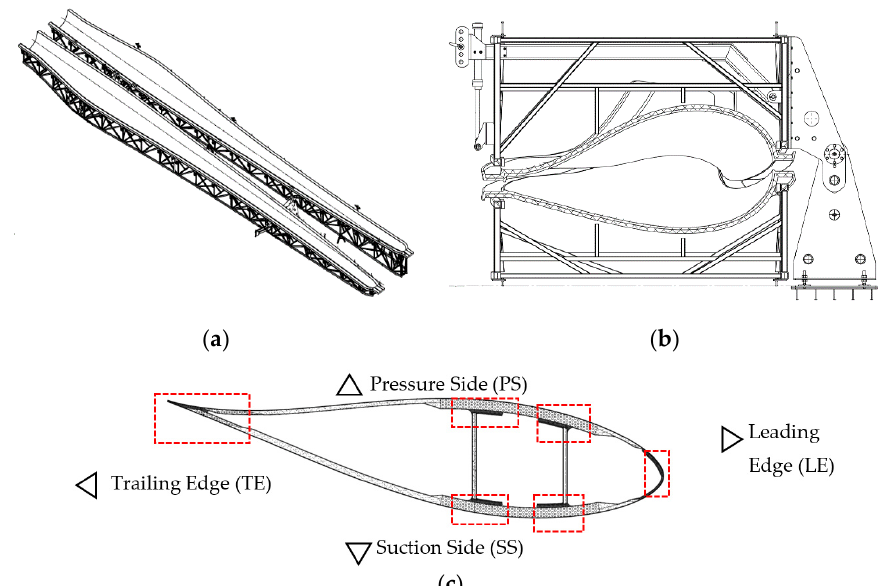
Figure 1. Schematic diagram of blade bonding: ( a ) blade mold in open state; ( b ) blade mold in a closed state; the parts of the blade in the mold were bonded; ( c ) schematic diagram of a blade section, and places of bonding are shown in the-red dotted box.